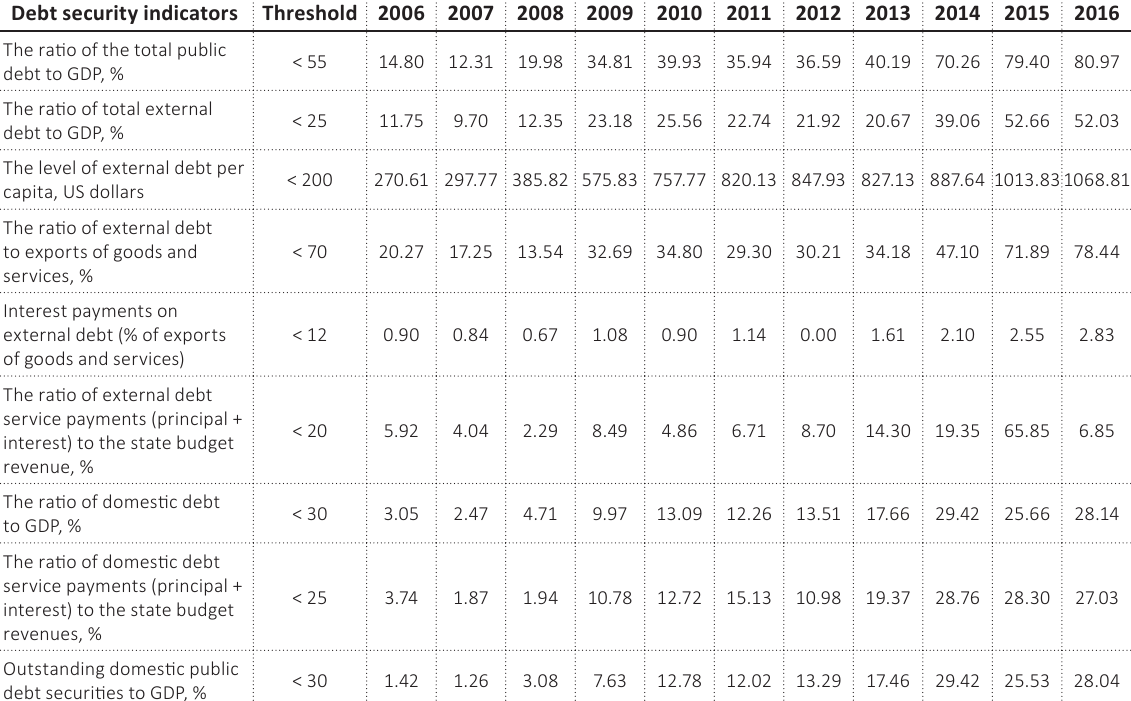
Source: Compiled by the authors.